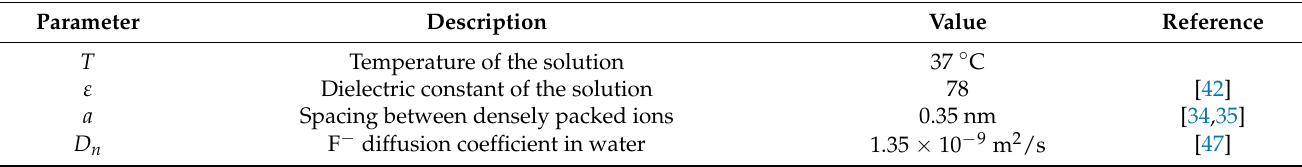
Table 1. Summary of the parameters used for the simulation